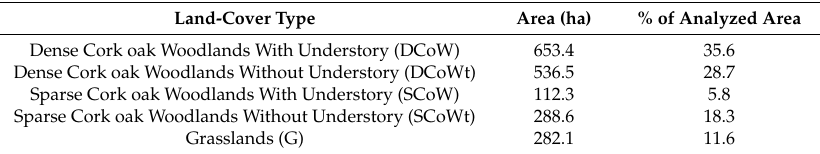
Table 2. Number of Landsat pixels over each land-cover type in the study